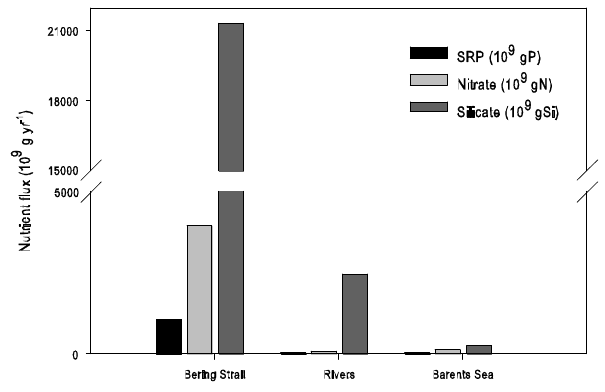
Fig. 5. Annual lateral influx of SRP (10 9 gP), nitrate (10 9 gN) and silicate (10 9 gSi) from Bering Strait, 8 circum-Arctic rivers (see text for details) and the Barents